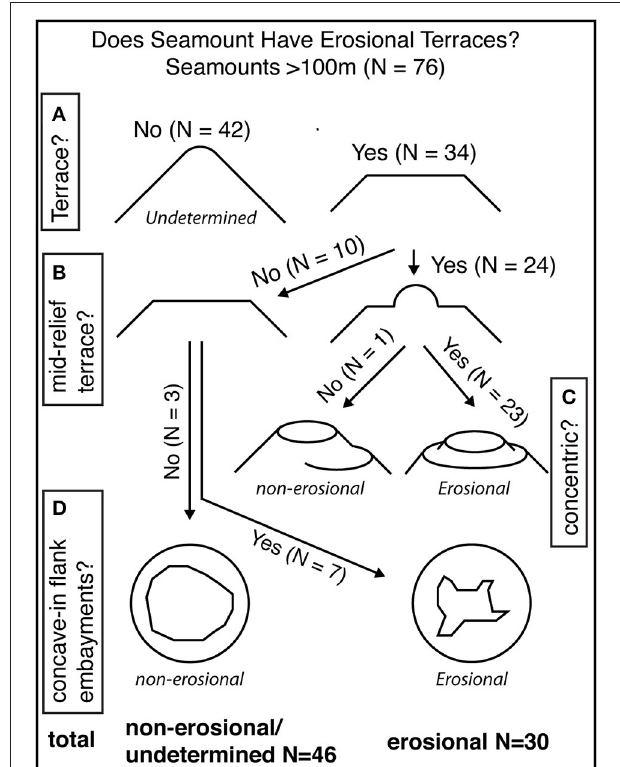
FIGURE 10 | Flow chart for extrapolating mapped terraces as erosional terraces indicating observations leading to, and the number of seamounts within, each classification step. See section Framework for Identifying Erosional Terraces for more detailed description of each classification step and discussion of false positives and negatives. (A) Initially seamounts are discriminated by the presence of bathymetrically identified terraces. Seamounts without bathymetrically identified terraces (left) cannot be positively identified as erosional. (B) Seamounts terraces occur on summits (left) or at mid-level on the seamount + / − a summit terrace (right). (C) Of seamounts with mid-level terraces, terraces can either occur non-concentrically (left) or concentrically (right) about the seamount’s summit. Seamounts with non-concentric terraces are classified as non-erosional, whereas seamounts with concentric terraces are classified as erosional. (D) For seamounts with summit terraces only seamounts are manually discriminated by the absence (left) or presence (right) of concave-in flank embayments. The former are classified as non-erosional and the later as